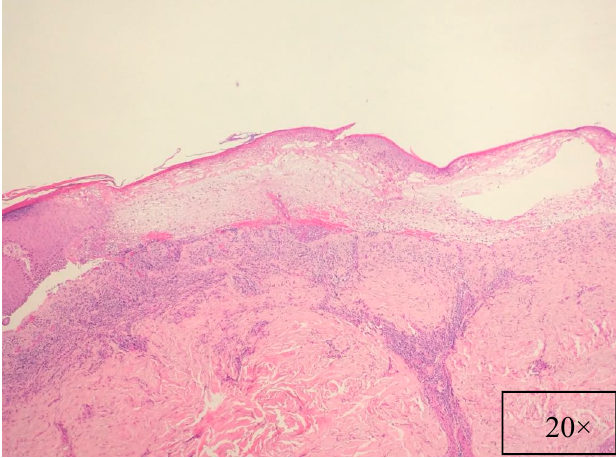
Figure 5. Intense, band-like inflammatory infiltrate, with minimal supra-basal acantholysis (H&E, magnification 20×).